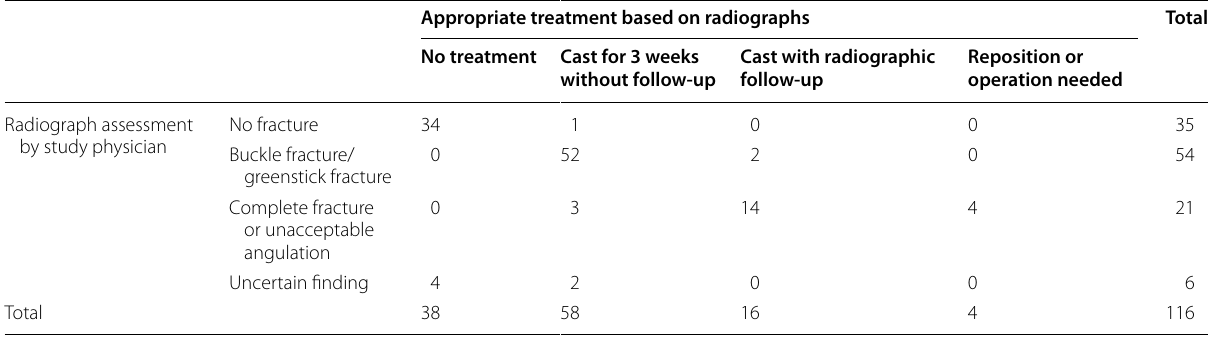
The radiologist’s interpretation is not shown here